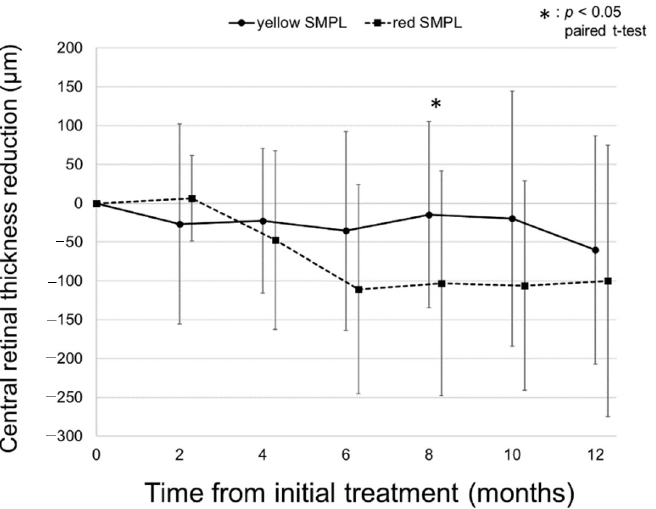
Figure 6. Comparison of the mean central retinal thickness (CRT) reduction in the two groups. There was no significant difference in the mean CRT reduction between the yellow and red subthreshold micropulse laser (SMPL) groups throughout the 12 months of the follow-up period except at 8 months from baseline, when the mean CRT reduction in the red SMPL group was greater than that in the yellow SMPL group ( p = 0.58, 0.65, 0.09, 0.02, 0.10, and 0.44 at 2, 4, 6, 8, 10, and 12 months from baseline).